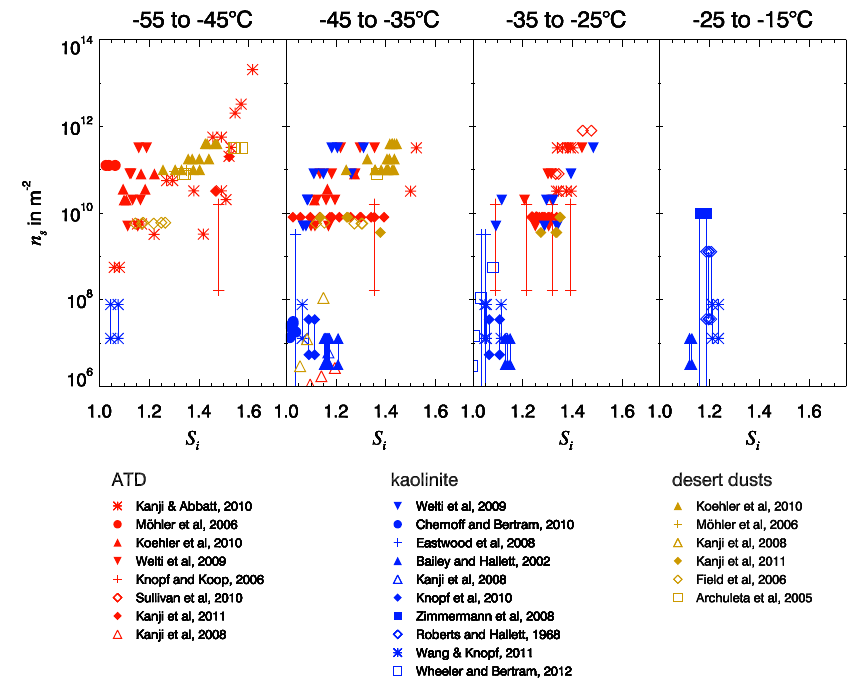
Fig. 14. INAS densities for ATD, kaolinite and desert dusts for deposition nucleation.